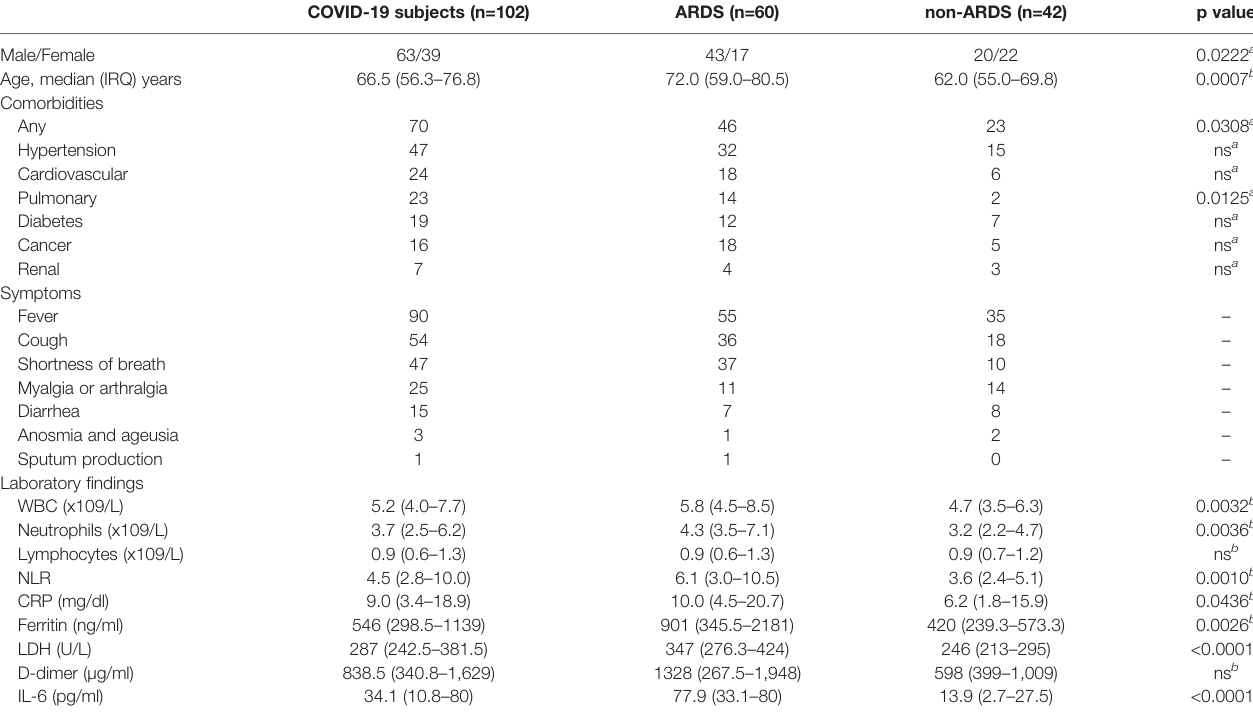
TABLE 1 | Demographic and clinical characteristics of COVID-19 subjects.